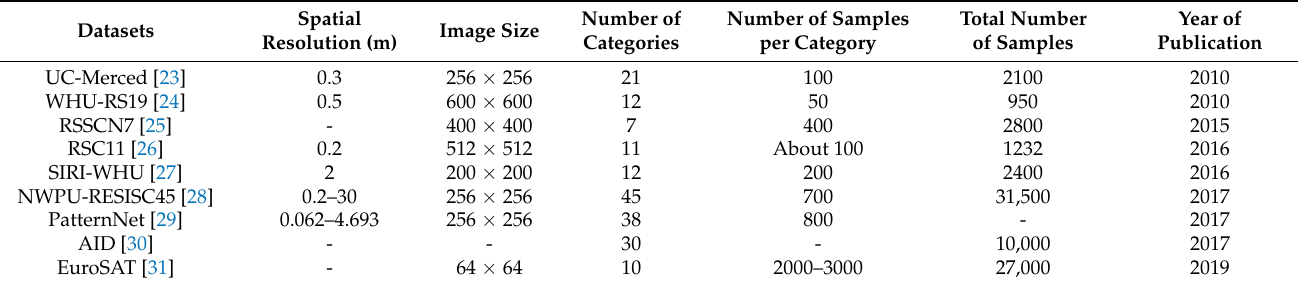
Table 1. Comparison of existing public